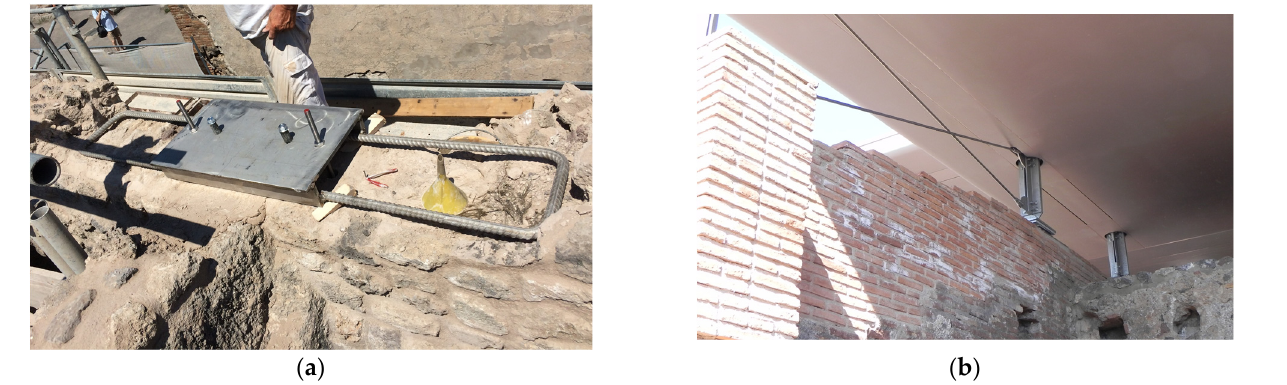
Figure 14. ( a ) Steel slab detail. ( b ) Steel rob detail.